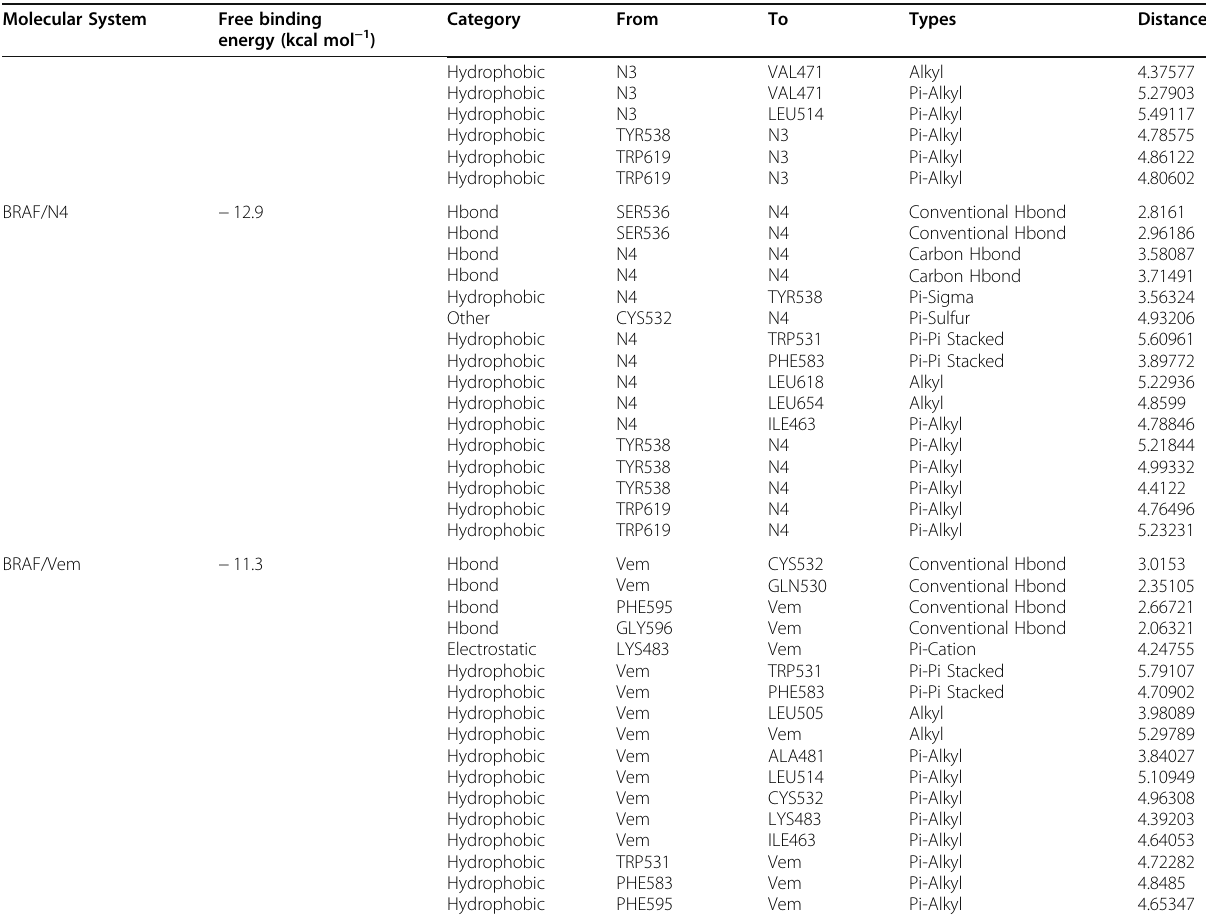
Table 3 Docking information for the interaction of designed compounds with V600E-BRAF (PDB ID: 3OG7) (Continued) Molecular System